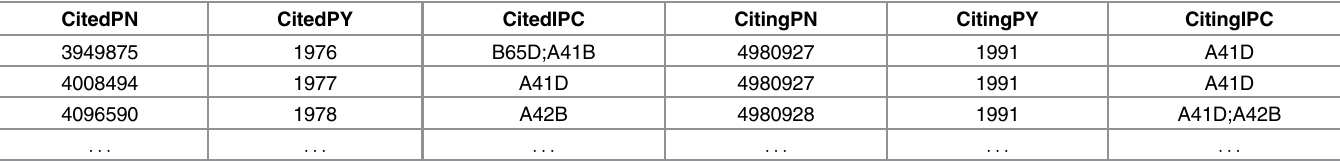
Table 6. An Example of Patents, Publication Year, and IPCs Mapping